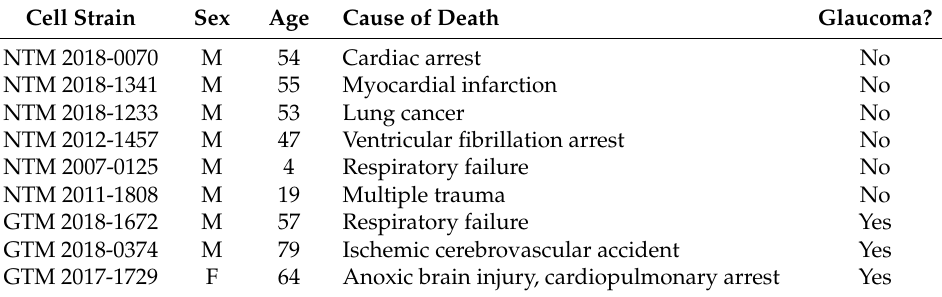
Table 1. Demographics of human donor